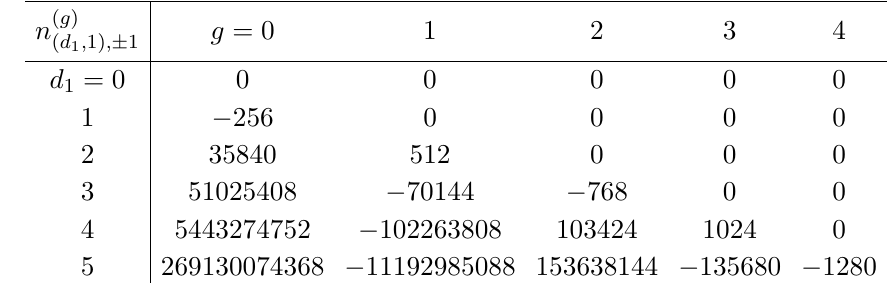
with Z charge ± 1 . 4 0